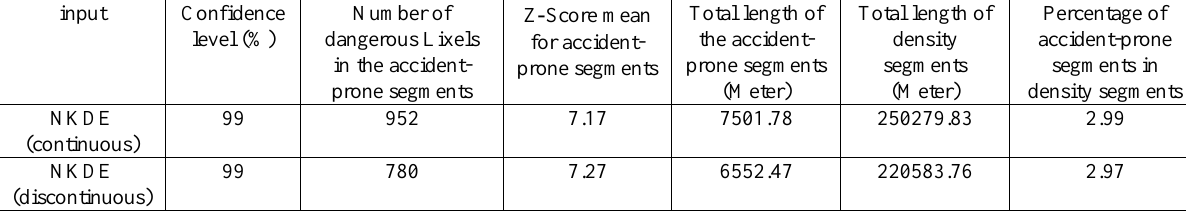
Table 4. Comparison of the results from the integration of NKDE method and Network-Constrained Getis-Ord Gi* statistics with the